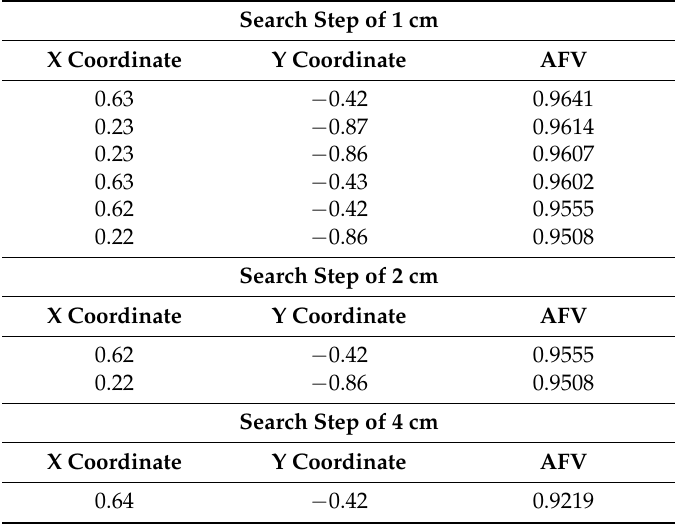
Table 3. The results of 1 m search scope under different step lengths (short baseline).